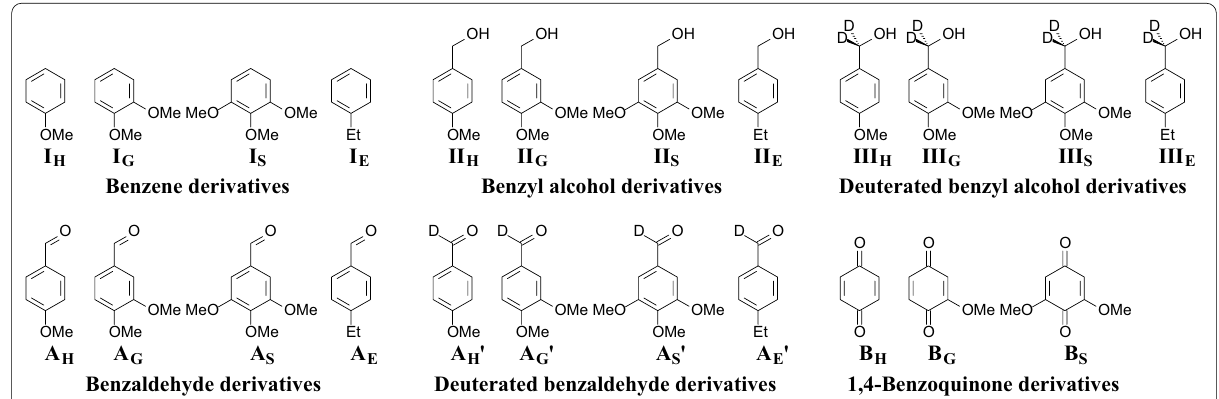
Fig. 1 Structure of monomeric C 6 -C 1 -type compounds used as starting materials and quantified exclusive major reaction products in our recent report